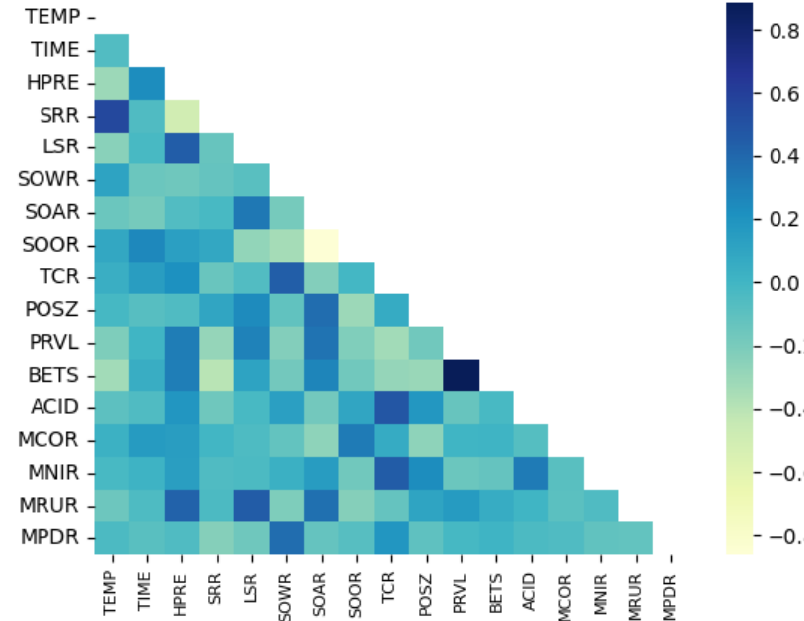
Figure 7. Pearson correlation coefficient matrix of all